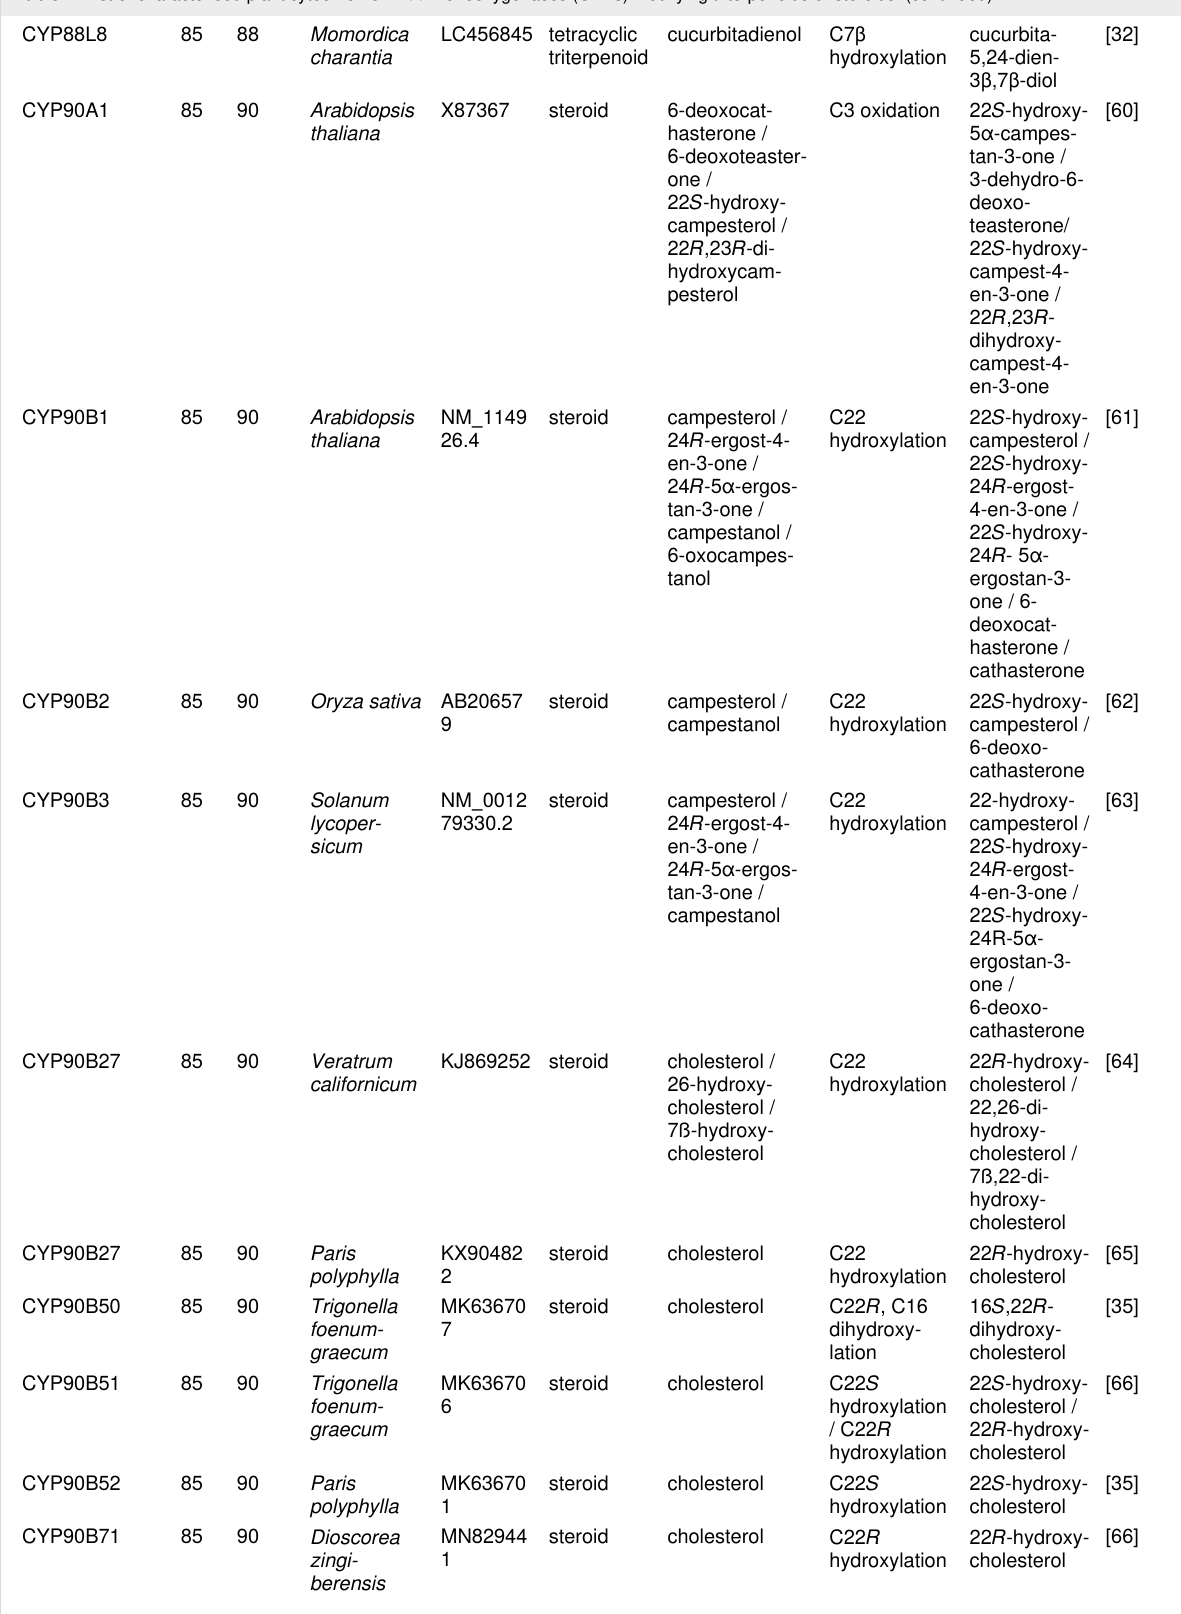
Table 1: List of characterised plant cytochrome P450 monooxygenases (CYPs) modifying triterpenoids or steroids. (continued)